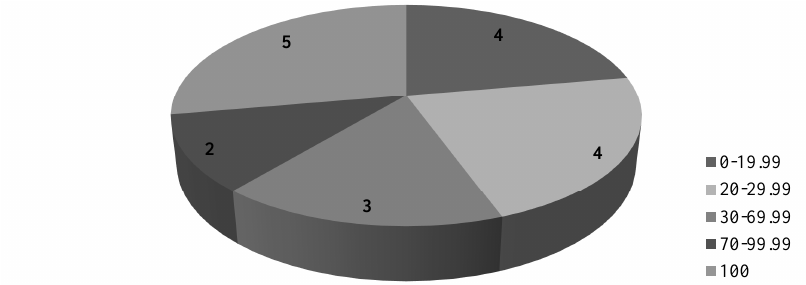
Figure 3. Number of cities in efficiency